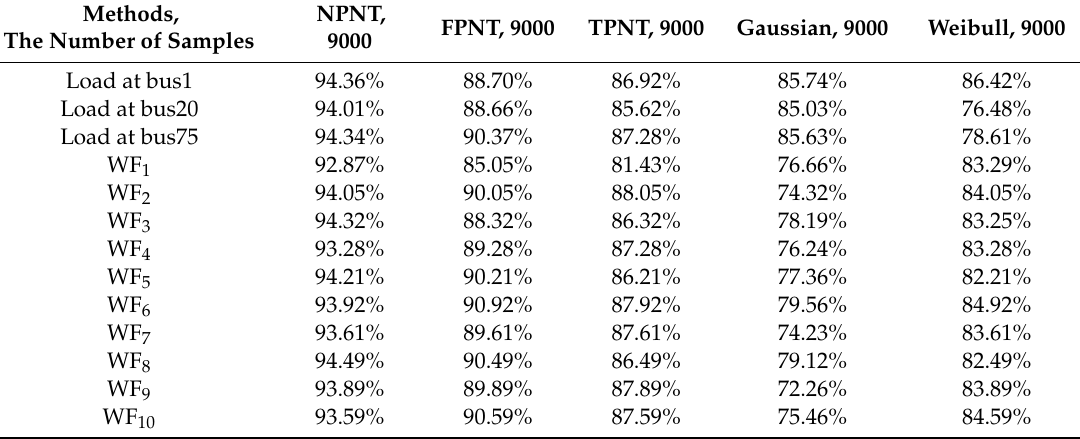
Table 3. Frequency histogram similarity indexes (FHSIs) obtained by NPNT, FPNT, TPNT, Gaussian, and Weibull